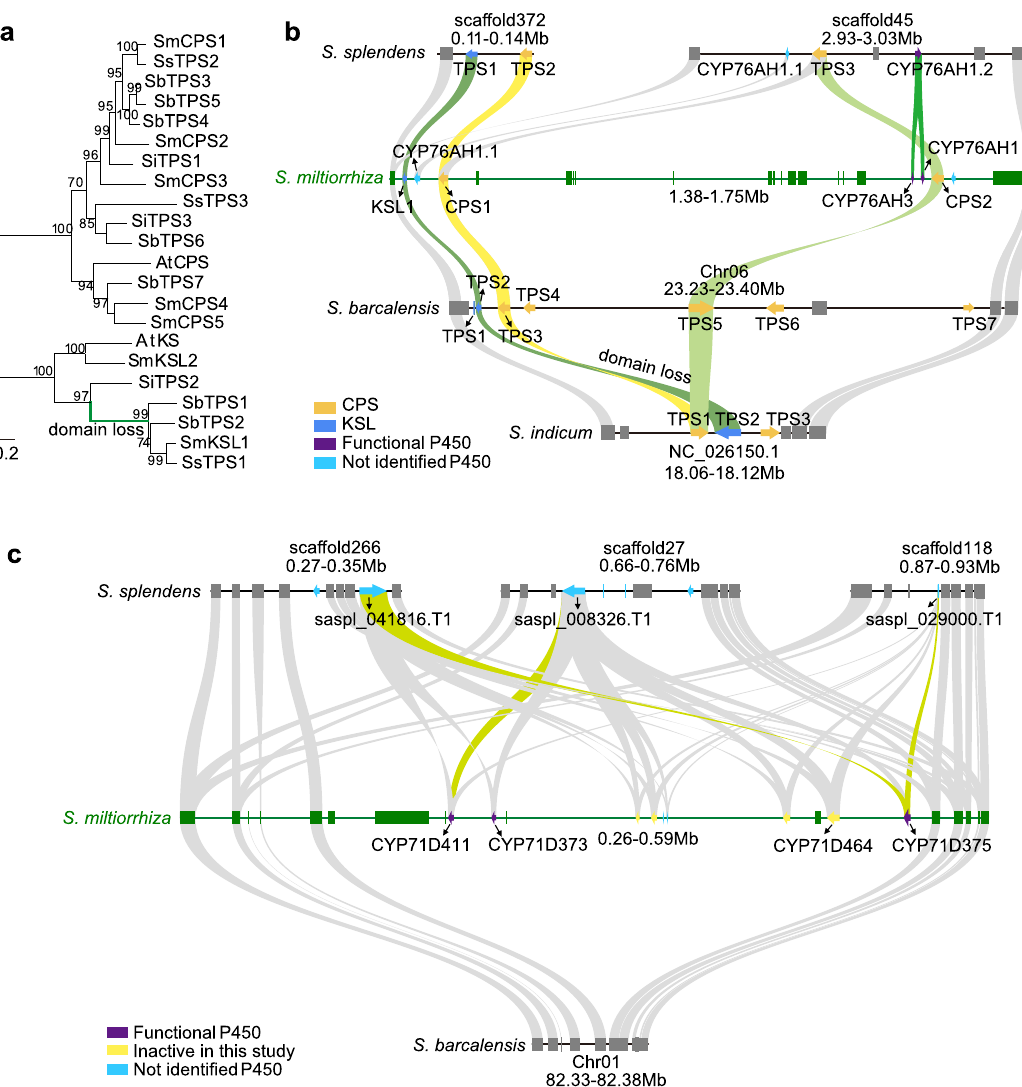
Fig. 8 Tandem duplication and syntenic analysis of genes involved in tanshinone biosynthesis. a ML phylogeney of diterpene cyclases and synthases from S. miltiorrhiza (Sm), S. splendens (Sp), S. baicalensis (Sb), S. indicum (Si) and A. thaliana (At). Bootstrap support values (percentages) from 1000 replicates are shown next to relevant clades. b Syntenic analysis of Danshen tanshinone biosynthetic gene cluster by comparison to S. splendens , S. baicalensis and S. indicum . c Syntenic analysis of the Danshen CYP71D subfamily gene cluster by comparison to S. splendens and S. baicalensis . Source data underlying Fig. 8b and c are provided as a Source Data fi